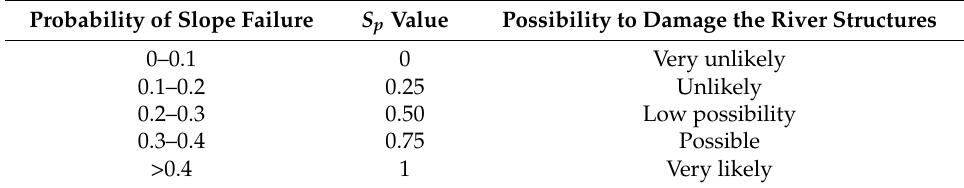
Table 3. S p for probability of slope failure near the